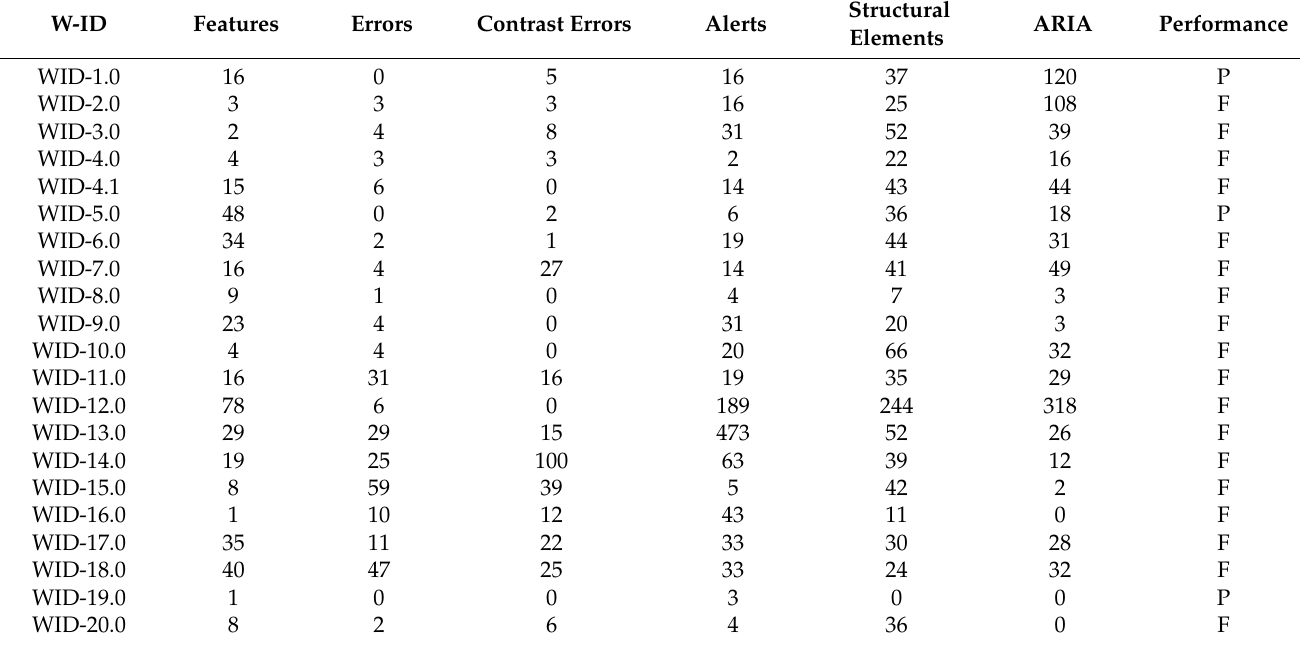
Table 7. Accessibility testing result for WAVE tool.